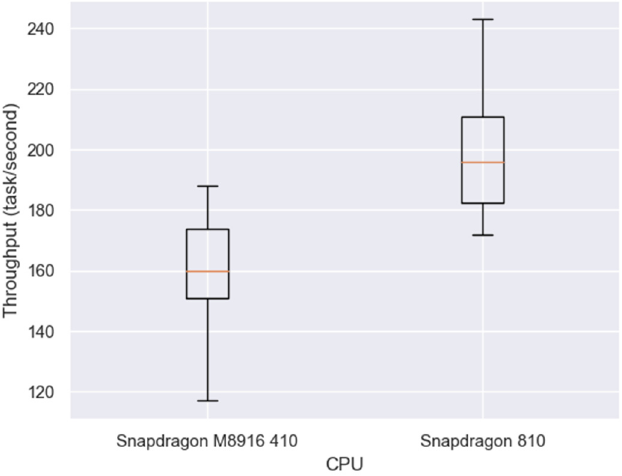
Figure 18. Under the premise of using CellS, the impact of different CPU core numbers on throughput.